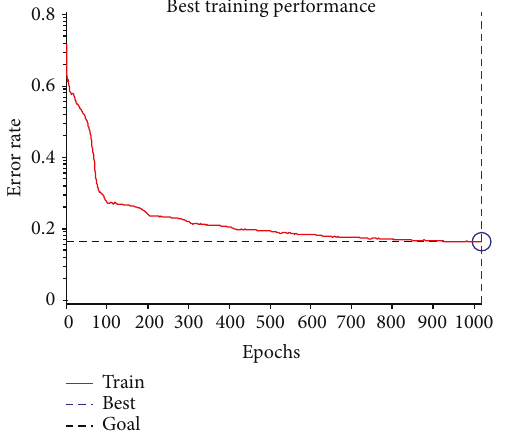
Figure 9: Network training of reinforcement engineering.